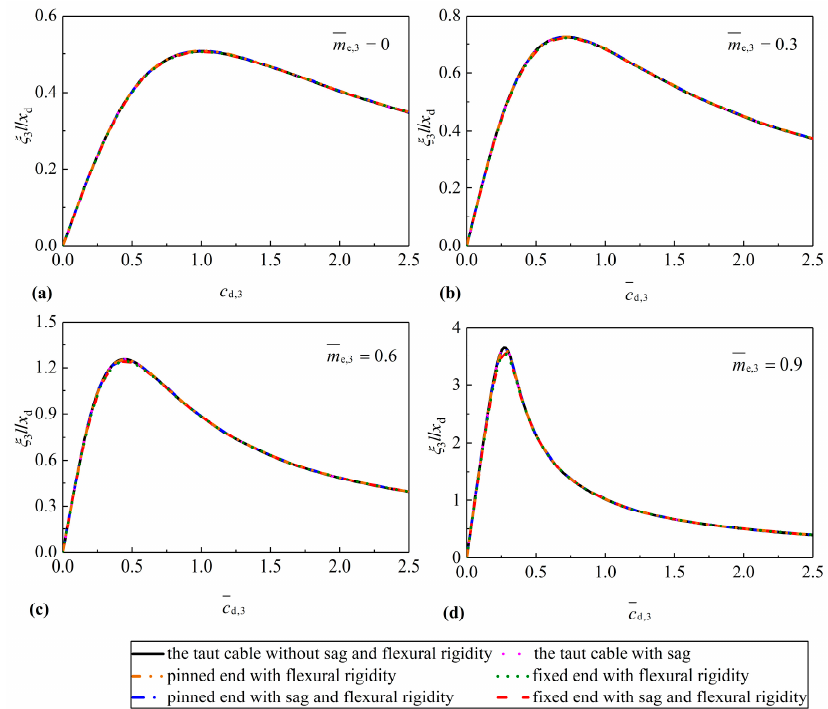
Figure 6. The third supplemental modal damping ratio of the short cable versus damping coefficient for various inertial masses: ( a ) m e,3 = 0; ( b ) m e,3 = 0.3; ( c ) m e,3 = 0.6; ( d ) m e,3 = 0.9.